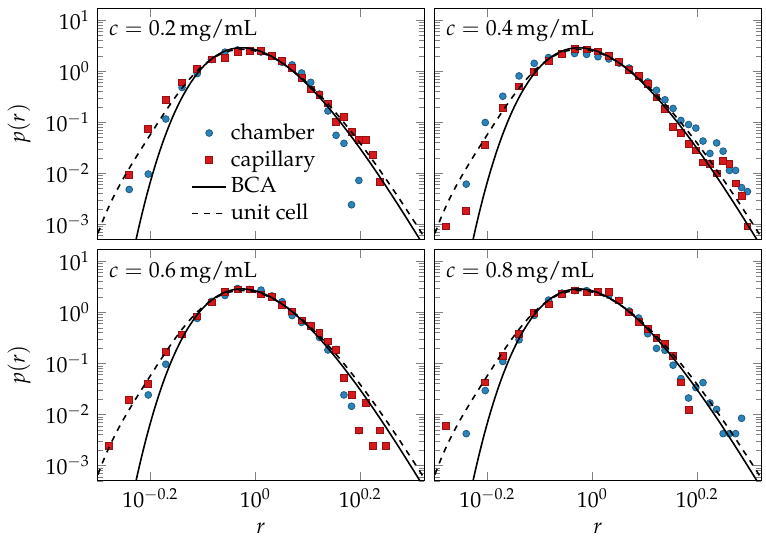
Figure 4. Reduced tube-width distribution: differently prepared F-actin experiments collapse onto a single master curve p ( r ) = RP ( rR ) , independent of both concentration and the degree of nematic order of the solution. The scaling and the shape of the equilibrium master curve, Equation (12), are predicted by the tube model, evaluated in the binary-collision approximation (BCA). Its deformation due to shearing is estimated using the unit-cell model. Small deviations between the data and the equilibrium theory are consistent with the predicted effect of a remnant strain γ = 1.5 (dashed lines) and interpreted as indicative of long-lived deformations of rare hairpin